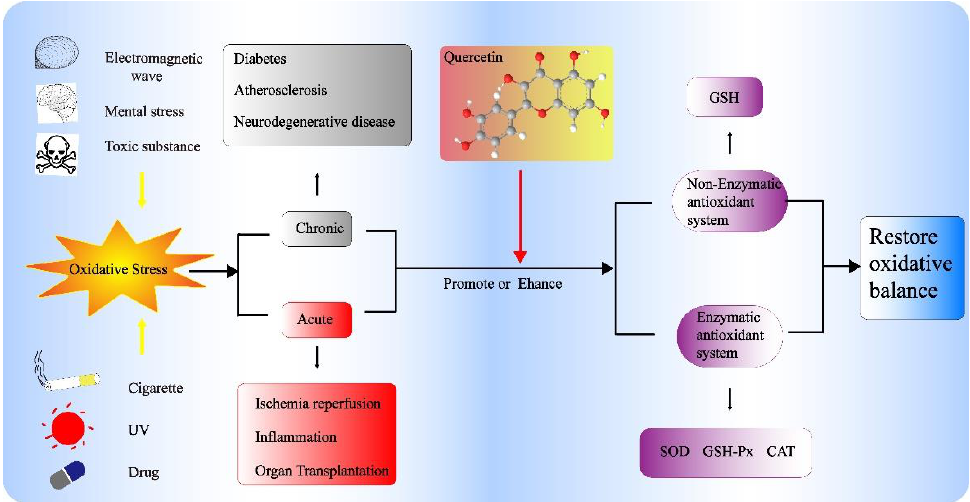
Figure 3. Basic principle of antioxidant activity of quercetin [78 – 81].